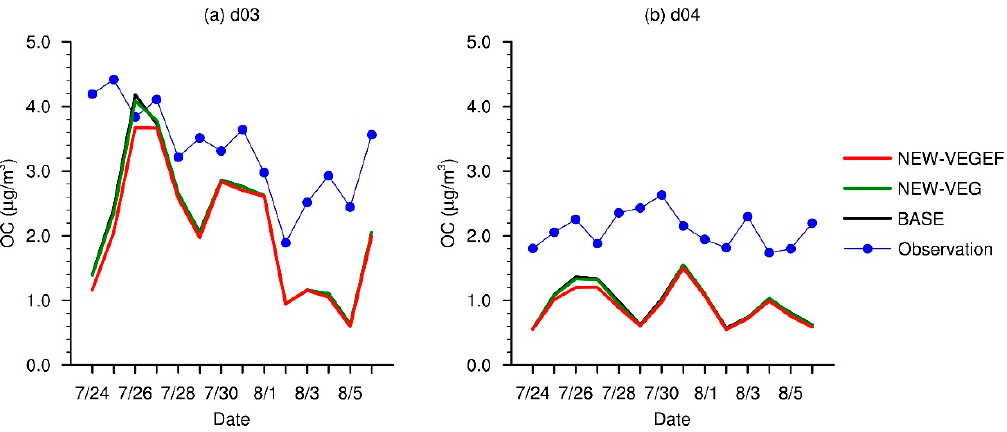
Figure 10. Time series comparisons of observed and simulated daily OC concentrations in the BASE, NEW-VEG, and NEW-VEGEF cases during the monitoring campaign in ( a ) d03 and ( b ) d04.